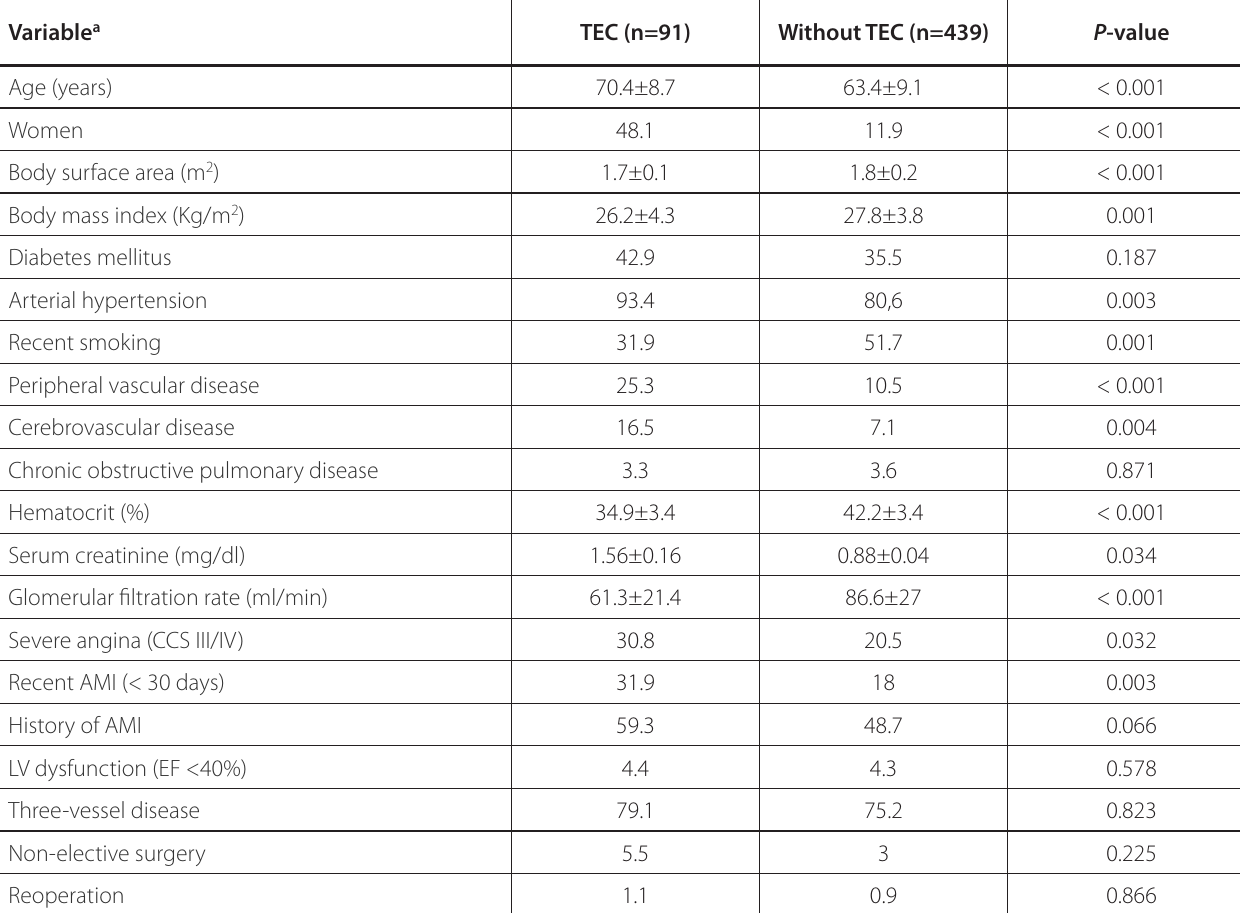
Table 3 . Univariate analysis of preoperative variables in groups of patients with (n=91) and without (n = 439) TEC during CPB. Variable a